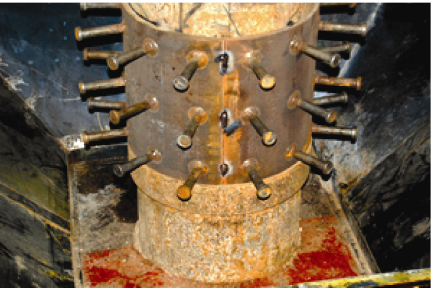
Fig. 11. Shear connection system after installation